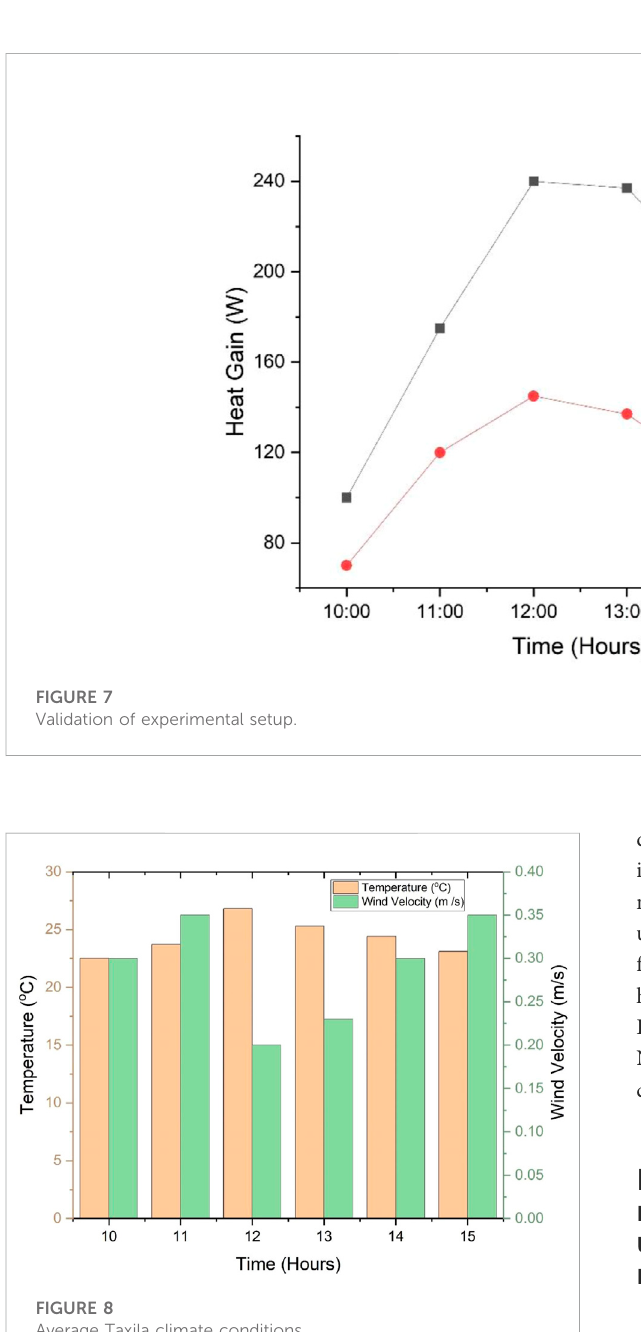
FIGURE 8 Average Taxila climate